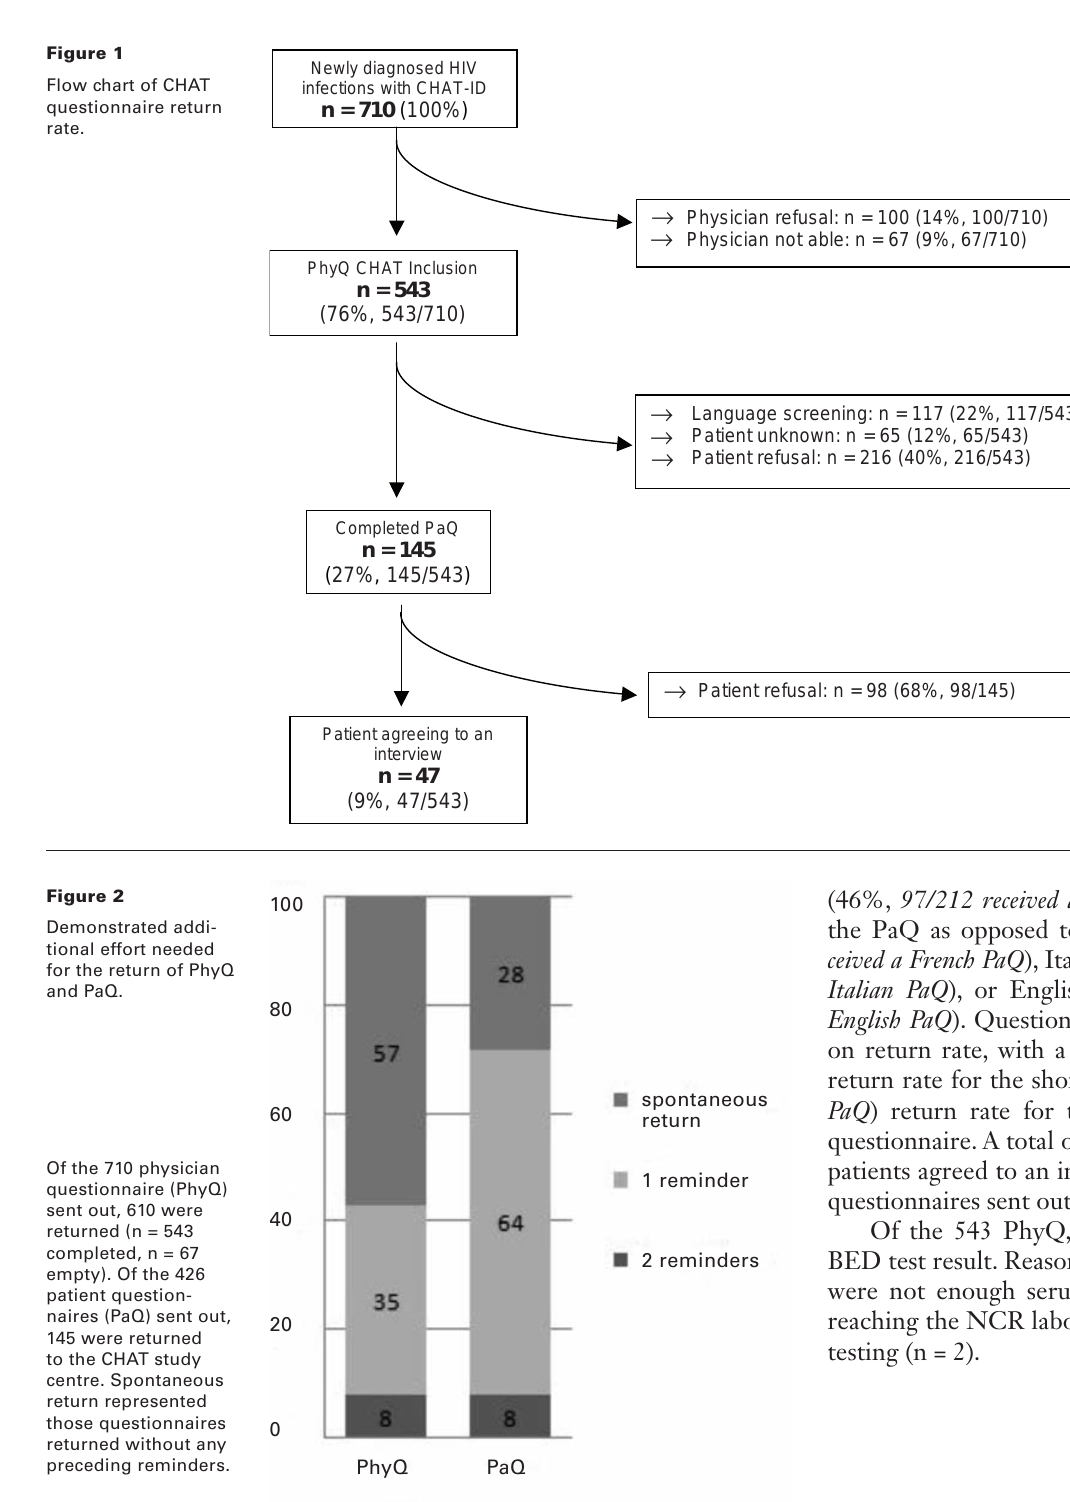
Flow chart of CHAT questionnaire return rate.